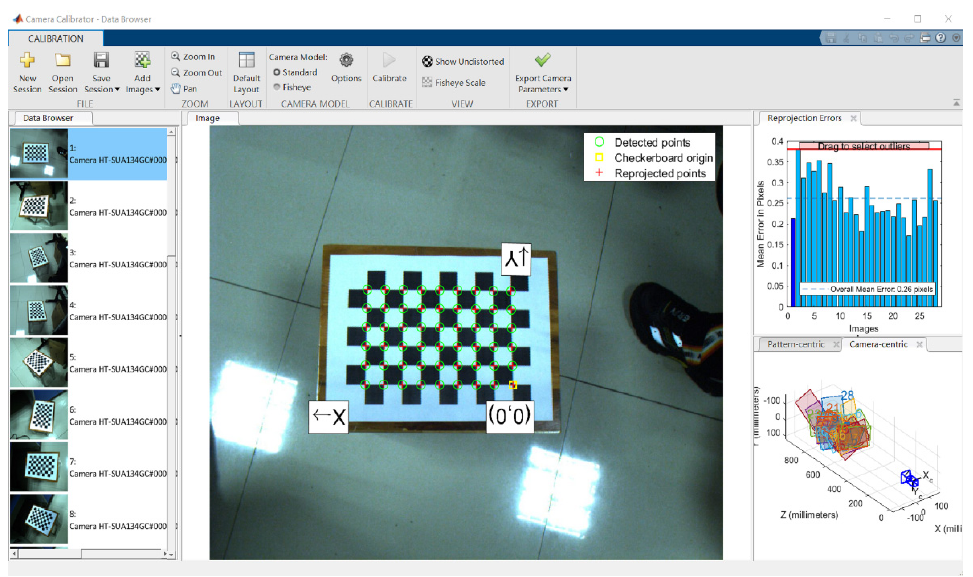
Figure 5. Camera calibration